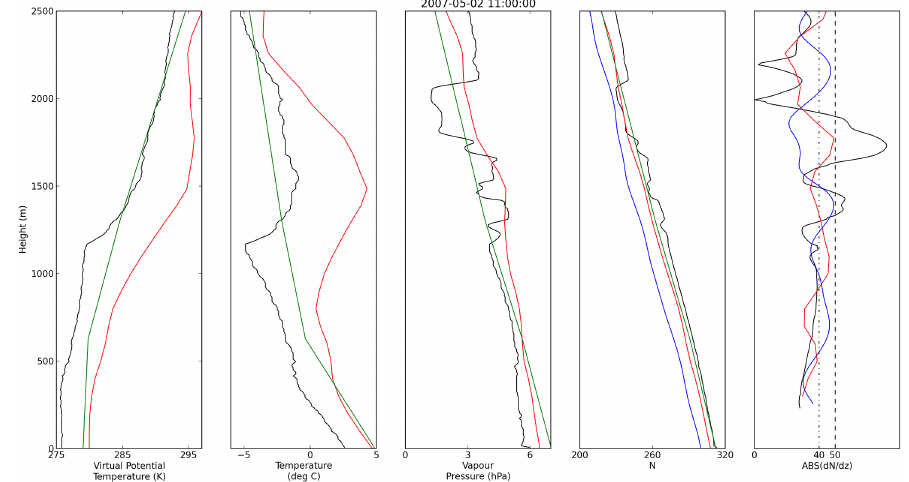
Figure 2. Profiles for 2 May 2007 at 11Z for MAC (black), COSMIC wet (red), COSMIC raw (blue), and ECMWF (green). Vertical dashed (dash-dotted) line represents the threshold defining main (secondary) break point.